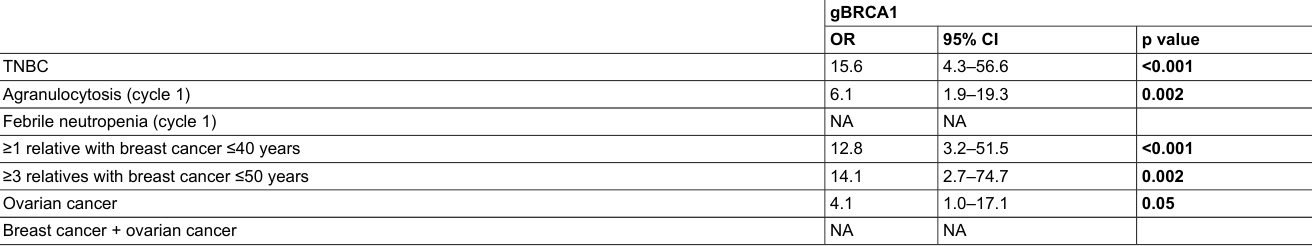
Table 4: Multivariate analysis of breast cancer patient characteristics, haematological toxicity during C1, and family history according to gBRCA1